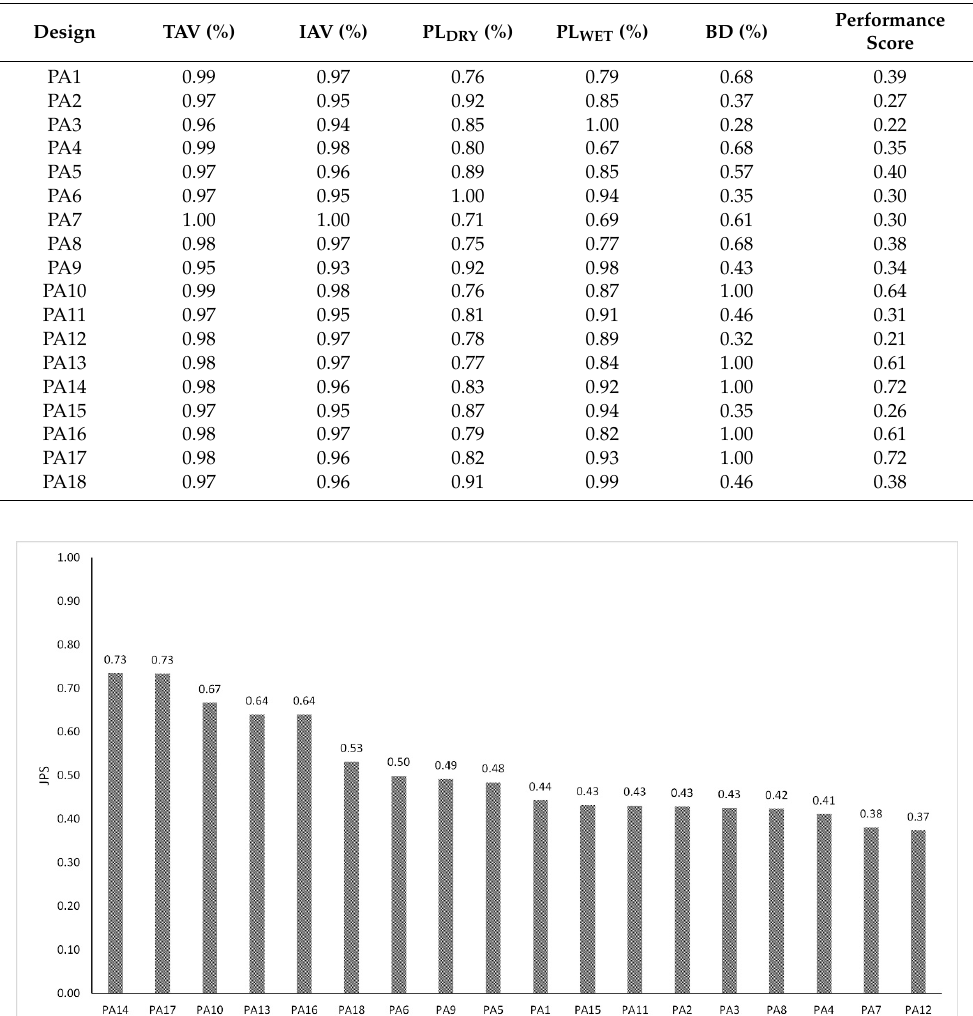
Table 12. Weighted normalized product model.